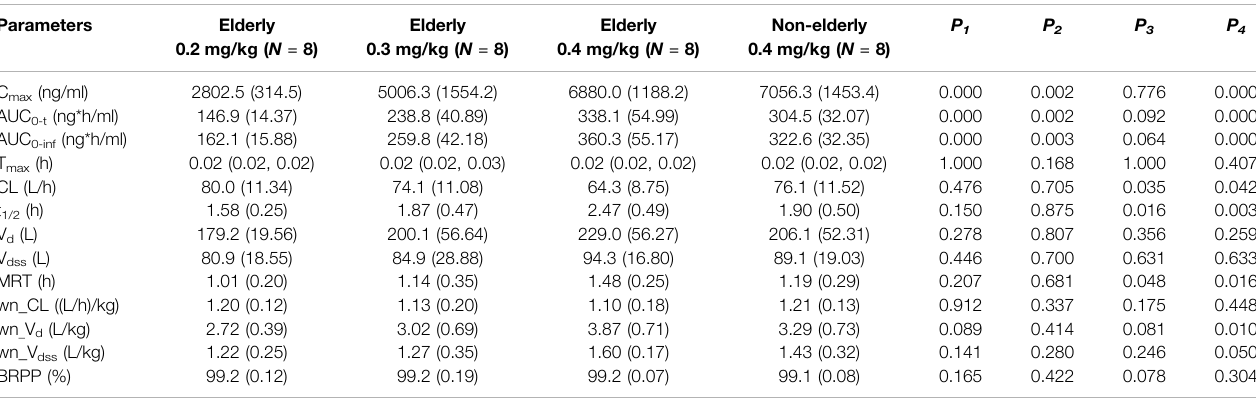
TABLE 3 | Pharmacokinetic characteristics of HSK3486.